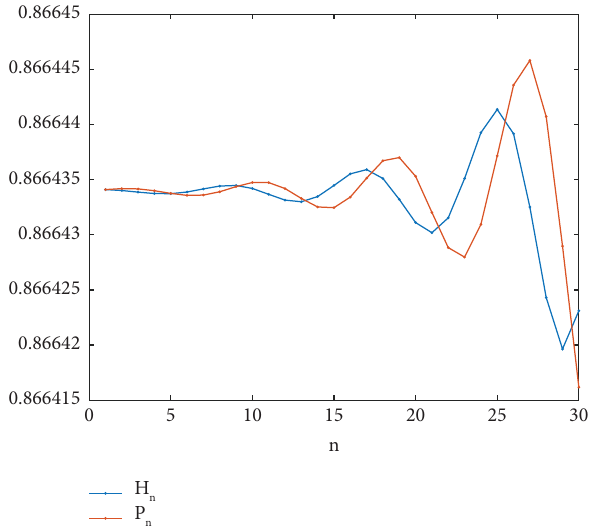
Figure 2: When R � 2 ,k � 1 , c